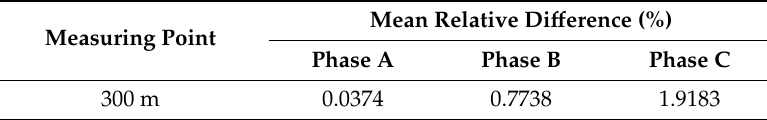
Table 4. Mean relative di ff erence of transient voltage in example